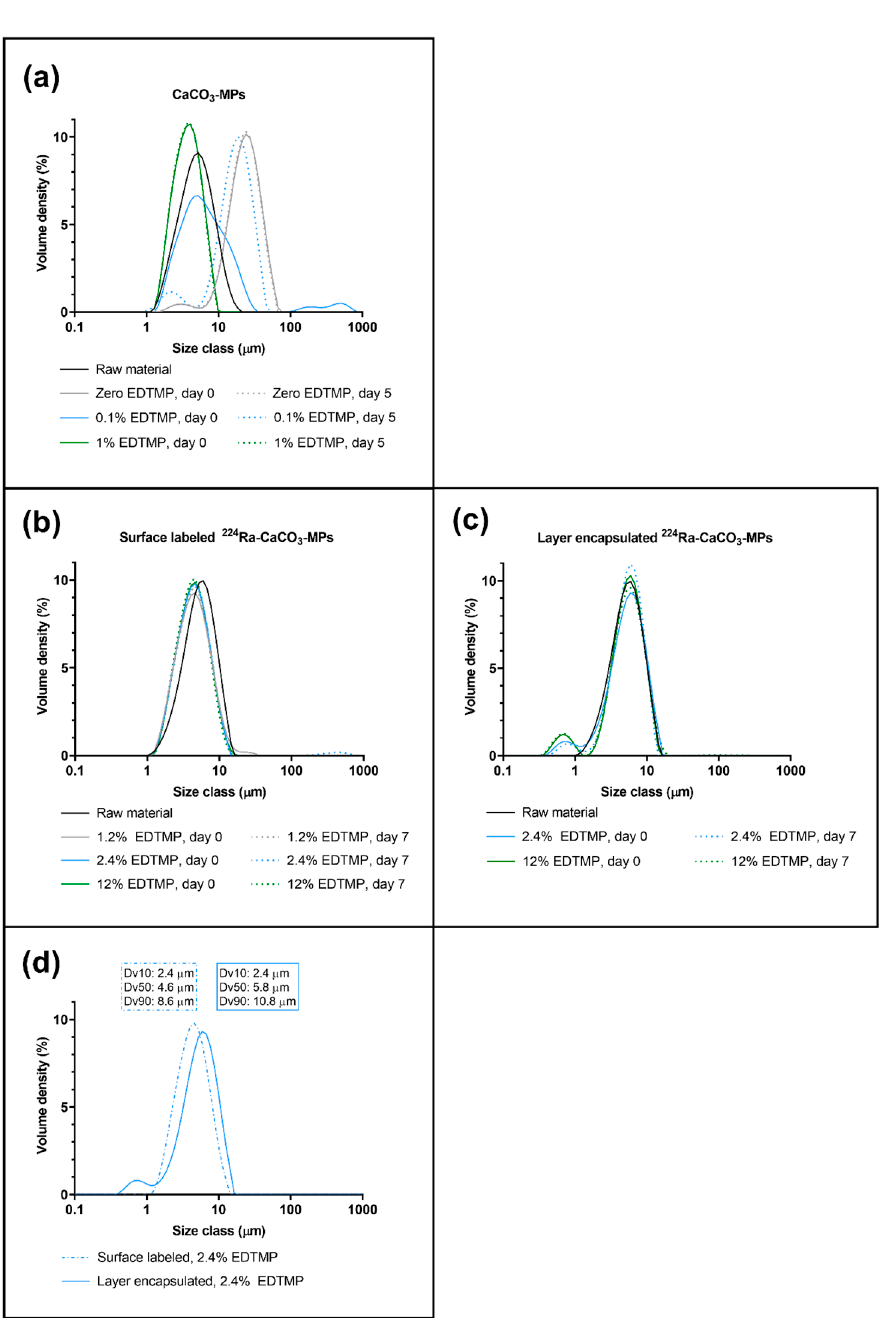
Figure 2. Size distribution of CaCO 3 microparticles. ( a ) Unlabeled, nonradioactive CaCO 3 MPs suspended in saline and autoclaved on day zero with varying EDTMP % ( w / w ) compared with the unautoclaved CaCO 3 MPs used as raw material. ( b ) Surface 224 Ra-labeled CaCO 3 MPs with varying EDTMP % ( w / w ) compared with the unautoclaved CaCO 3 MPs used as raw material. ( c ) Autoclaved and layer-encapsulated 224 Ra surface-labeled CaCO 3 MPs with varying EDTMP % ( w / w ) compared with the unautoclaved CaCO 3 MPs used as raw material. ( d ) Comparison of surface-labeled and layer-encapsulated surface-labeled MPs, excerpts from ( b , c ) Dv: volumetric diameter, with Dv10 being the 10th percentile, etc.